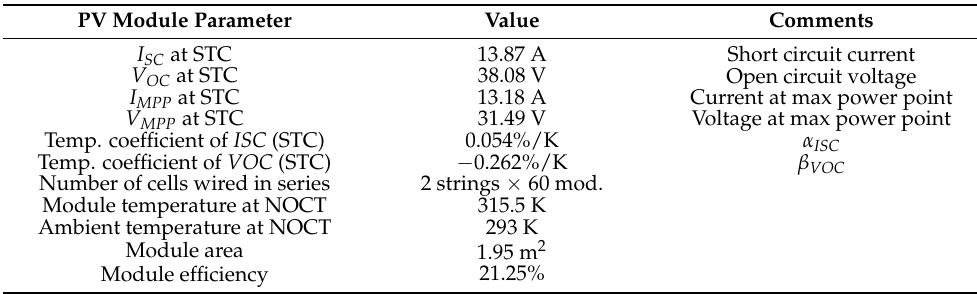
Table A3. Technical data of the 415 Wp monocrystalline silicon, 120 half-cells PV panels NU JC415 [40], as used in TRNSYS